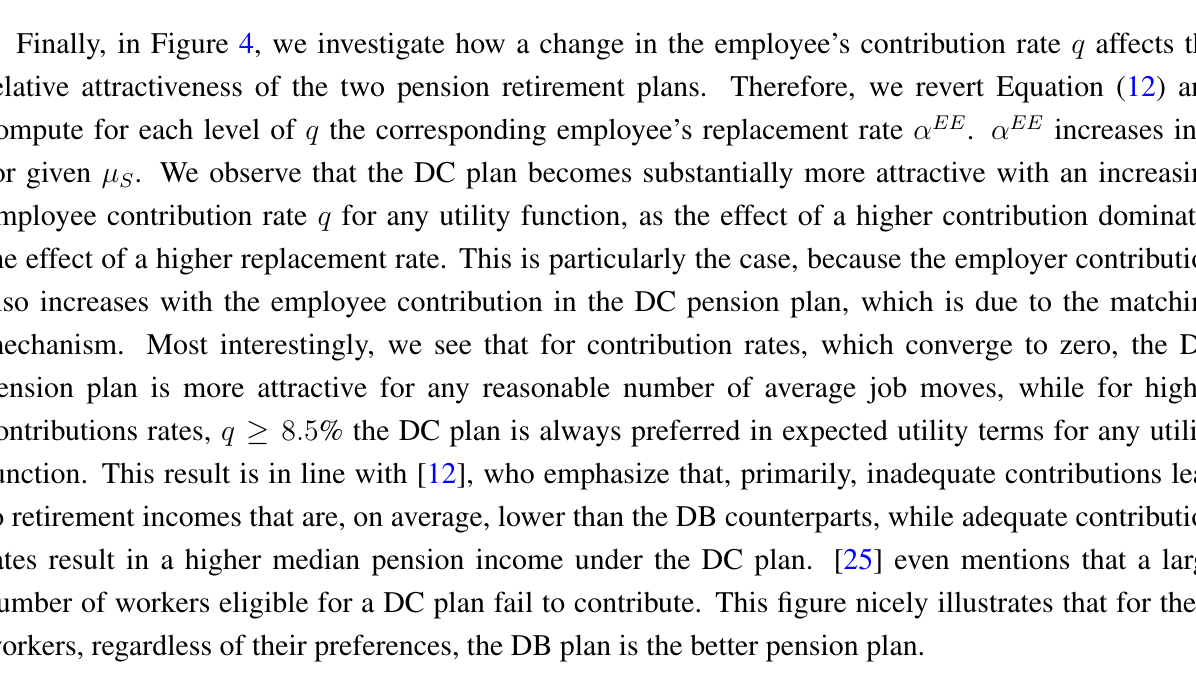
Figure 4. Values for the indifference switching λ ∗ for different levels of the employee’s contribution rate q